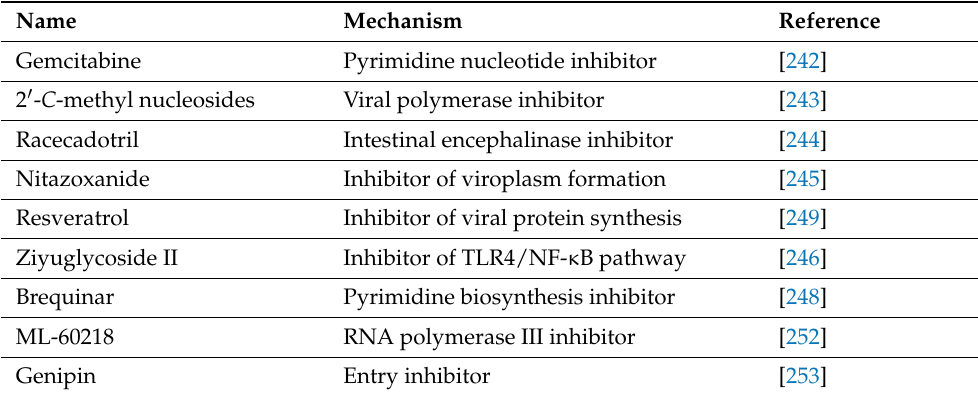
Table 4. Potential anti-rotavirus